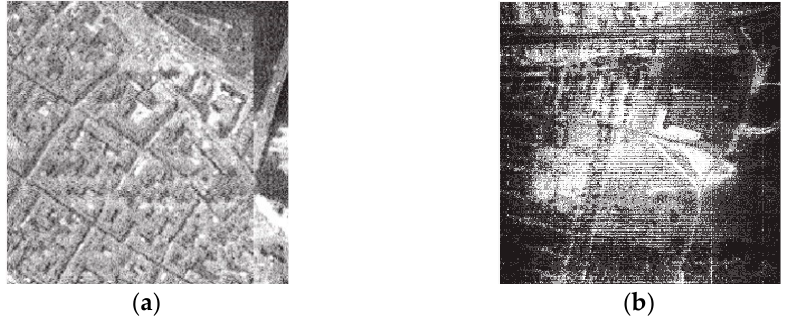
Figure 1. Observed HSIs contaminated by mixed noise. ( a ) The second band image of Pavia University dataset; ( b ) the 139th band image of URBAN dataset.